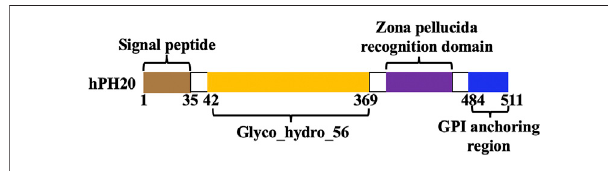
FIGURE 1 | Structural domains of